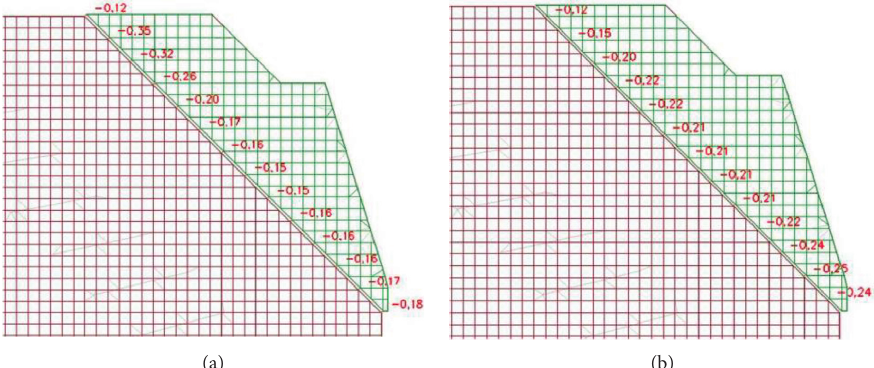
Figure 13: The stresses (MPa) in the assumed sliding surface of the rock for the dead load: (a) normal stresses, (b) shear